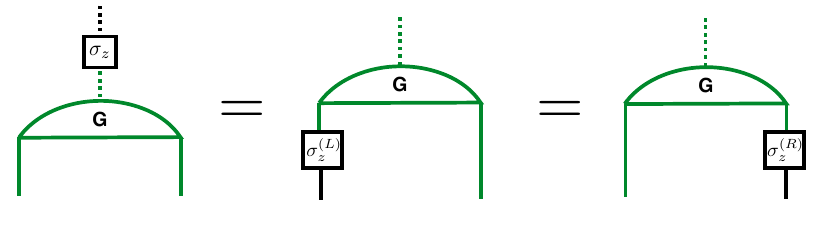
Figure 5. Pushing (cid:27)